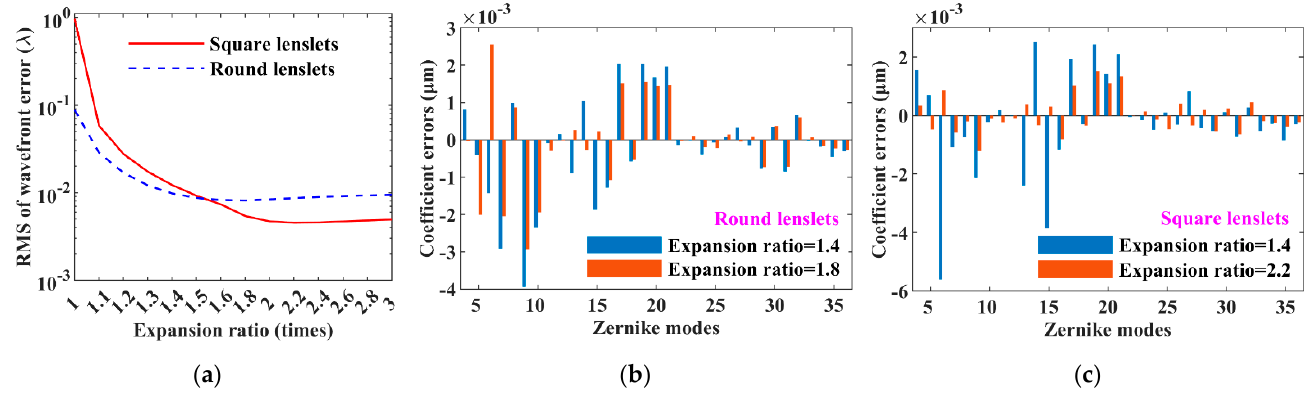
Figure 3. Effect of zero-padding on the performance of vSHWS. ( a ) RMS varying with expansion ratio; Zernike coefficient errors at optimized and non-optimized expansion ratios when using ( b ) round and ( c ) square lenslets, respectively.